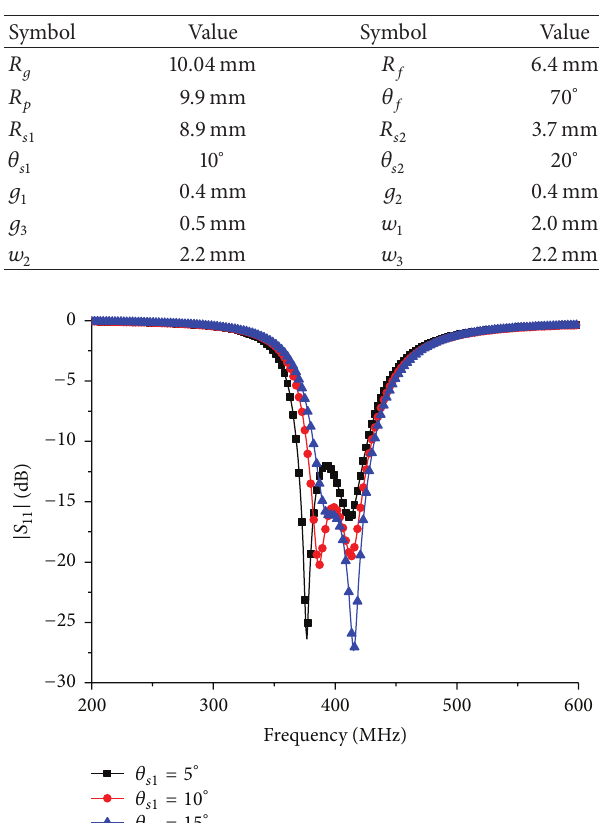
Table 1: Antenna design parameters.